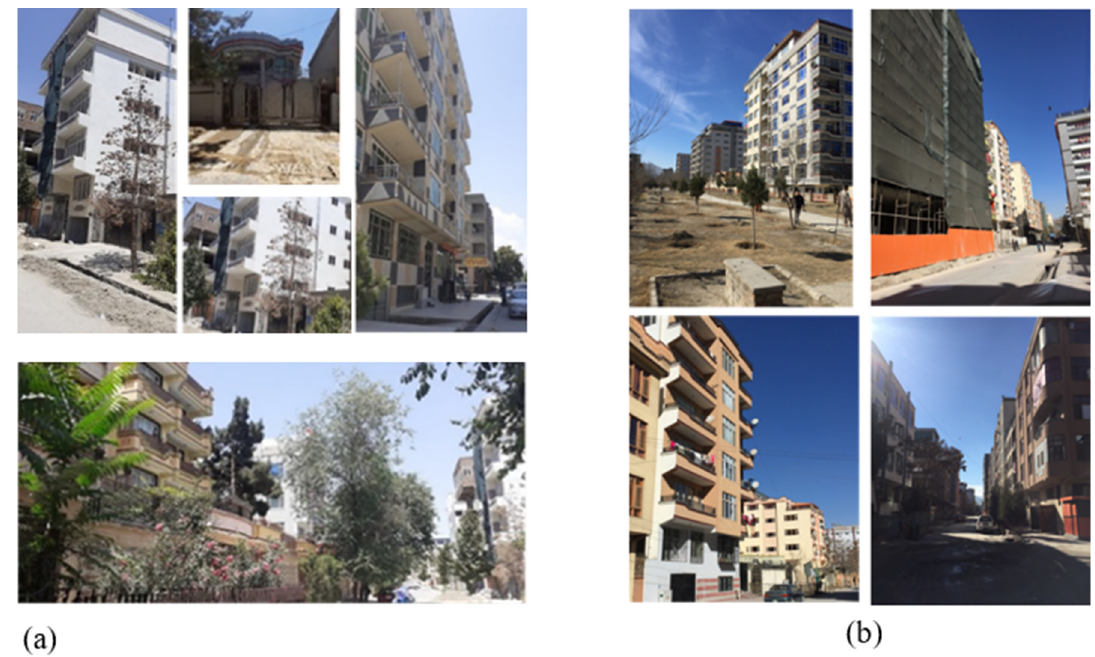
10 of 28 Table 2. Statistic of Transformed Houses in Study Areas. No